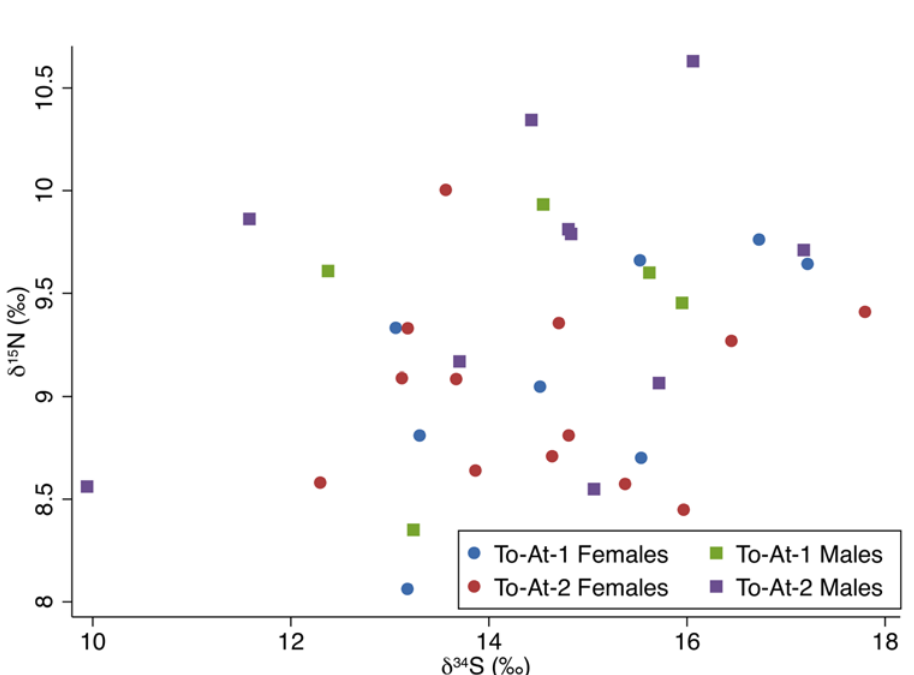
Fig 6. δ 34 S and δ 15 N values plotted by sex and burial mound. The δ 34 S outlier (To-At-2/27A) is labeled.